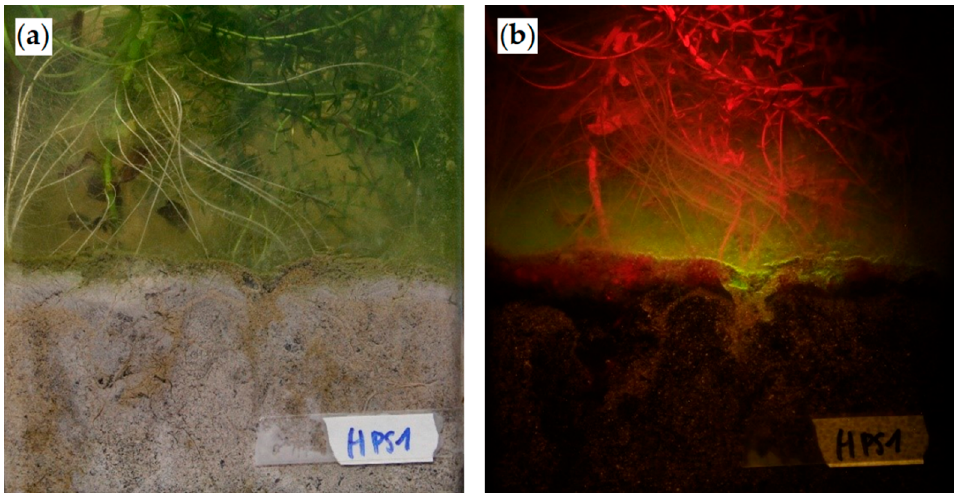
Figure 3. Example of planted rhizotrons after the inoculation of fluorescent E. coli (3rd day after inoculation). ( a ) Rhizotron under natural light. ( b ) Rhizotron under fluorescence conditions